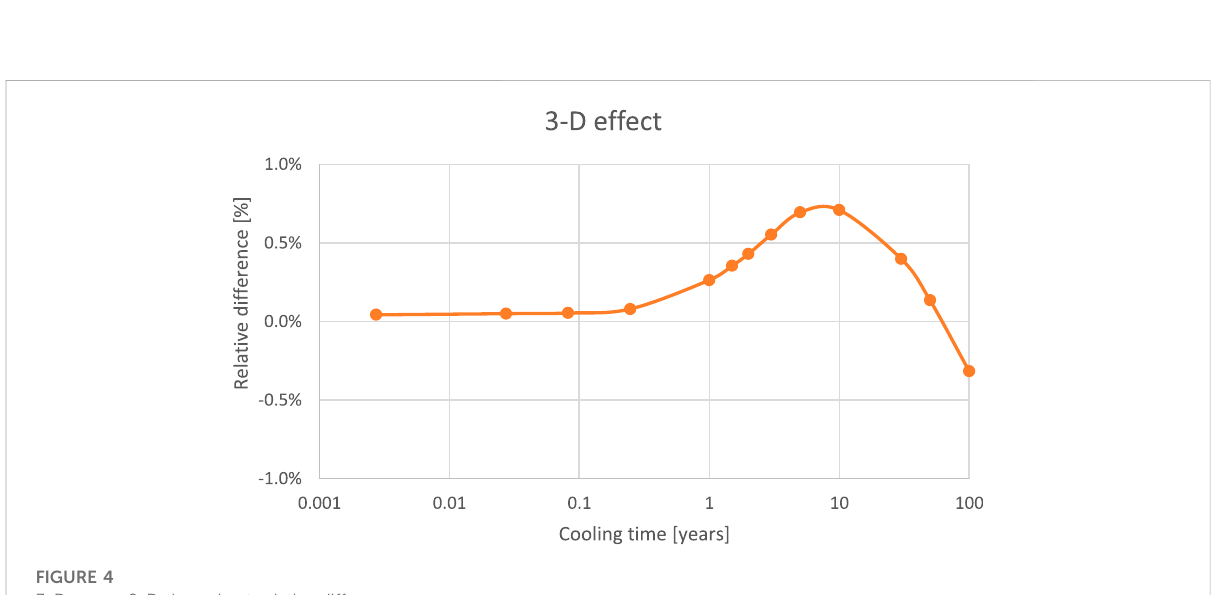
3-D versus 2-D decay heat relative